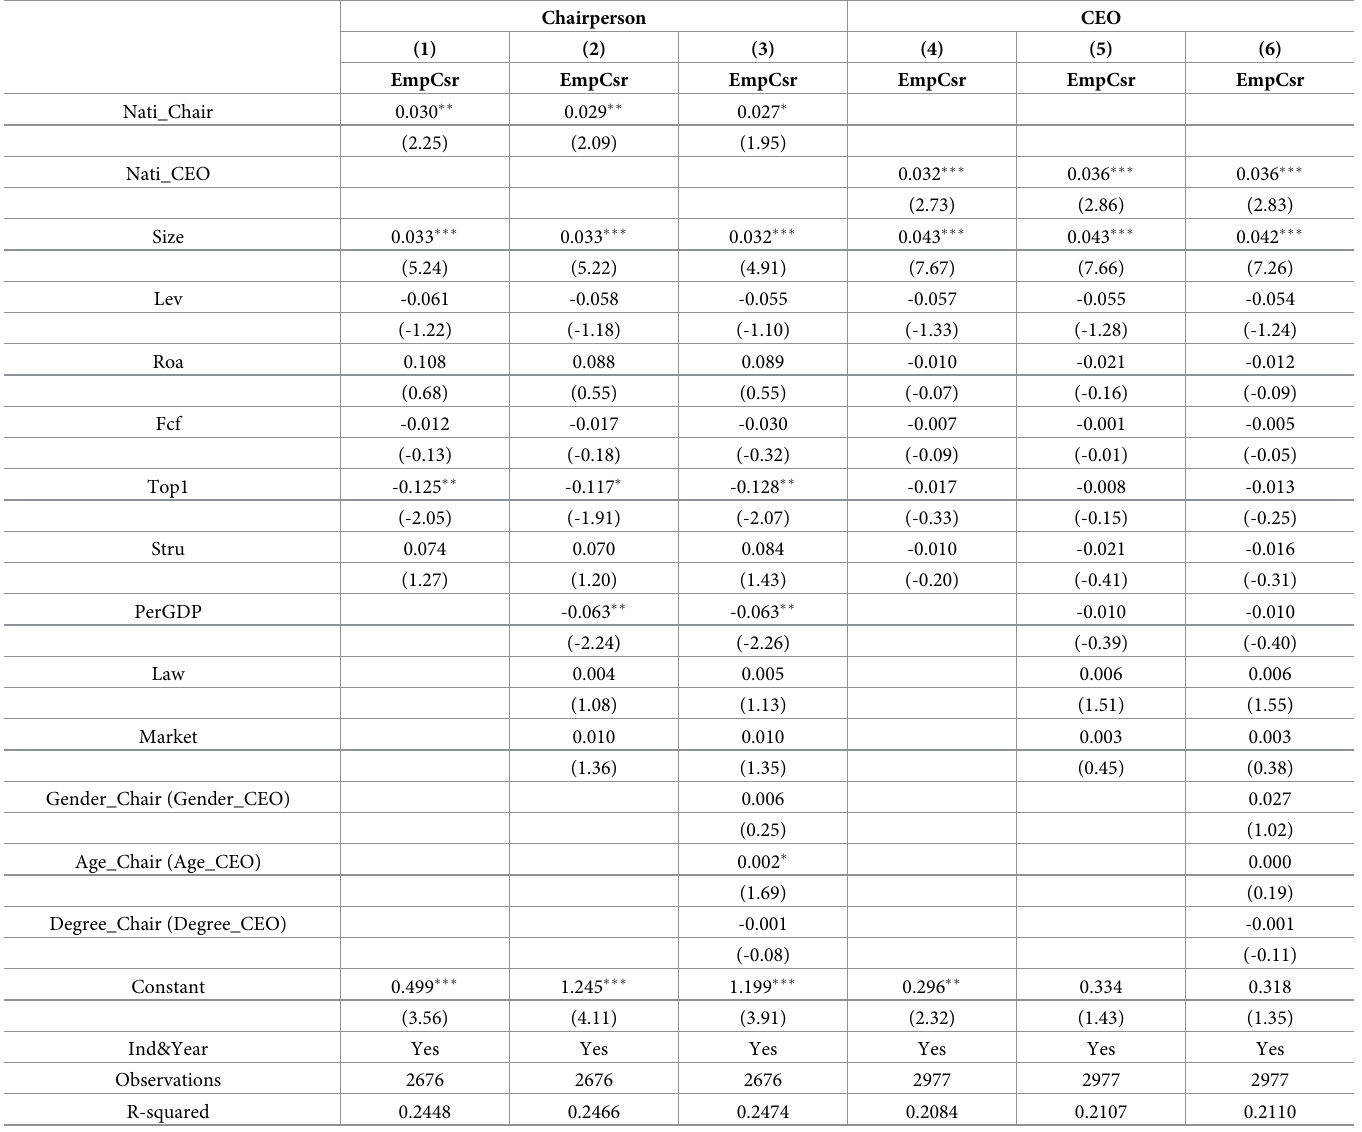
Table 3. Home bias of senior executives and employee social